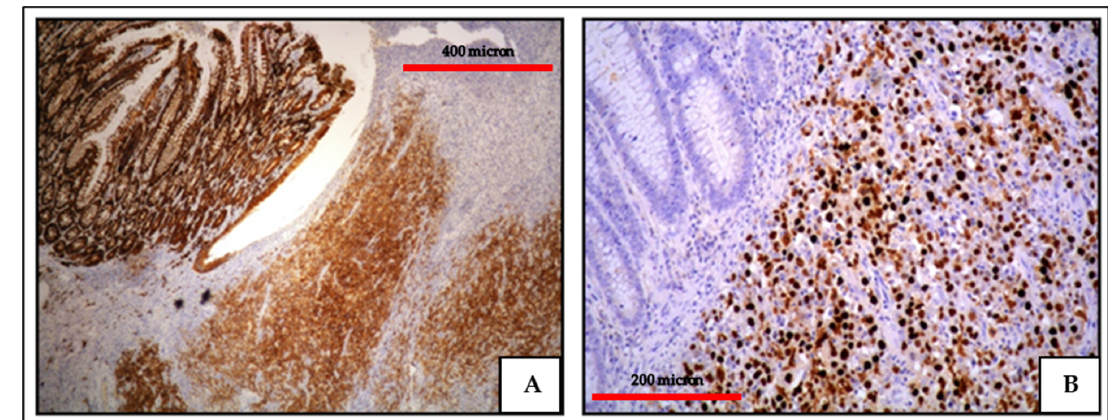
Figure 2. ( A ) PBL of the colon: MUM18 expression of the neoplastic proliferation (immunostaining, Ventana immunostainer, magnification 100×; original image from Prof Ascani); ( B ) PBL of the colon: diffuse EBV positivity of the neoplastic cells (EBER ‐ ISH , magnification 200×; original image from Prof Ascani).